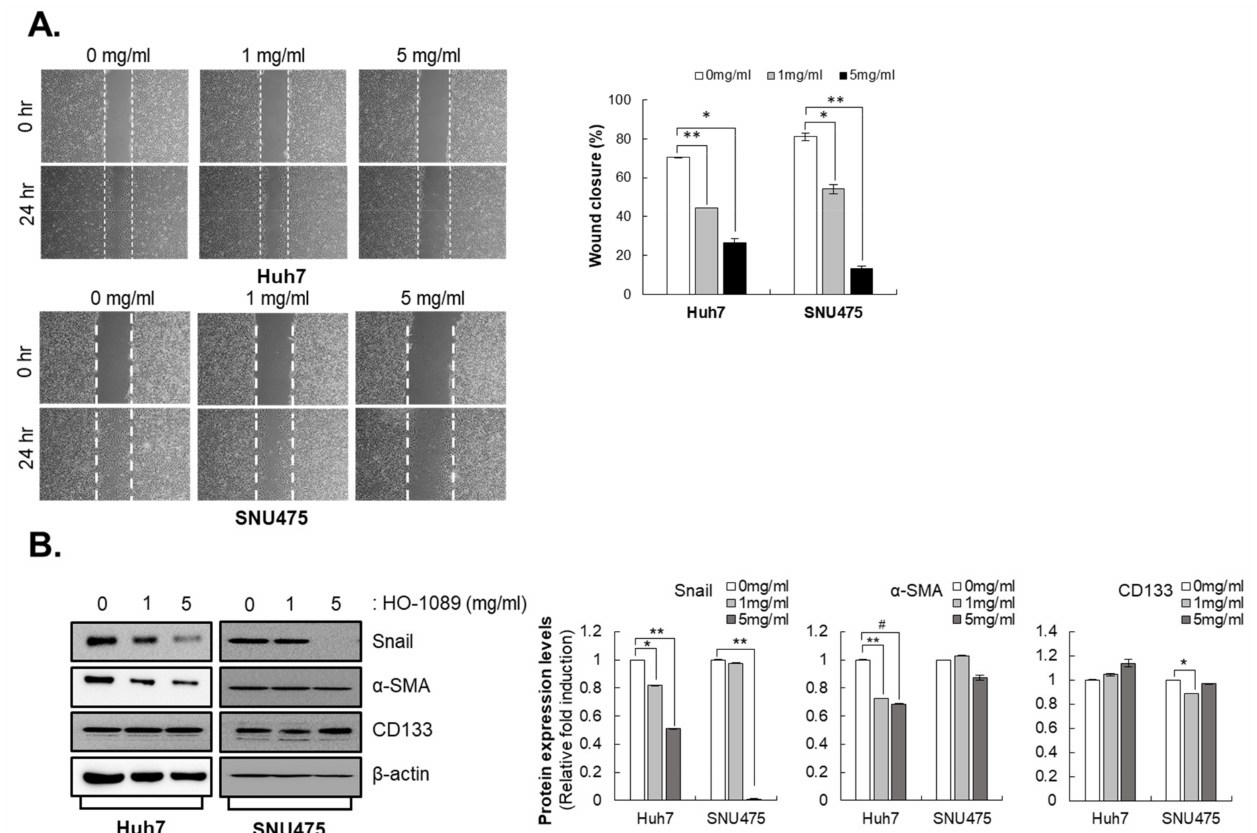
Figure 3. Inhibition of metastasis capacity by HO-1089 treatment: ( A ) Migration capacities of Huh7 and SNU475 cells were examined after treatment concentrations of HO-1089 at 0, 1, or 5 mg/mL for 24 h (left panel). The percentage of wound closure, which is calculated the area with no cells using image J software (right panel). ( B ) The EMT-related proteins, Snail and a-smooth muscle actin (SMA) and liver cancer stemness protein CD133, were detected when Huh7 and SNU475 cells were treated with 0, 1, or 5 mg/mL HO-1089 for 48 h (left panel). The Western blot images were quantitatively analyzed (right panel). Data are expressed as means ± SD ( n = 3). * p < 0.05, ** p < 0.005, # p < 0.0005 compared to the control